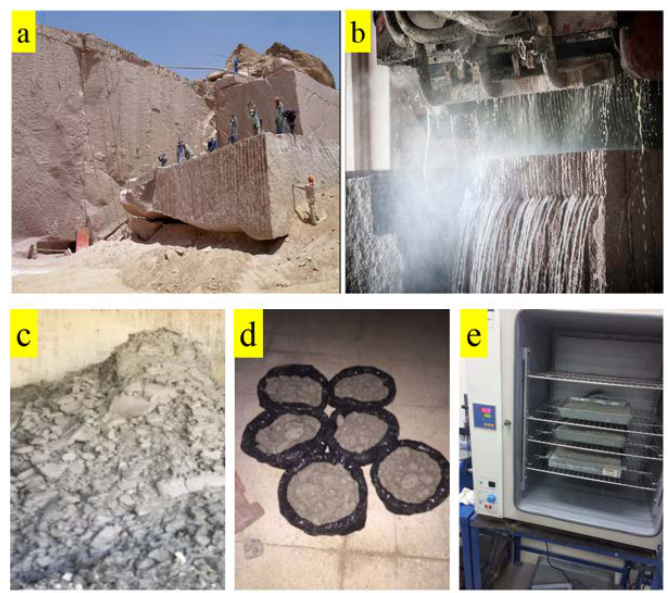
Figure 2. ( a ) Granite quarry site; ( b ) stone cutting process at the Saudi Marble and Granite Factory Co.,